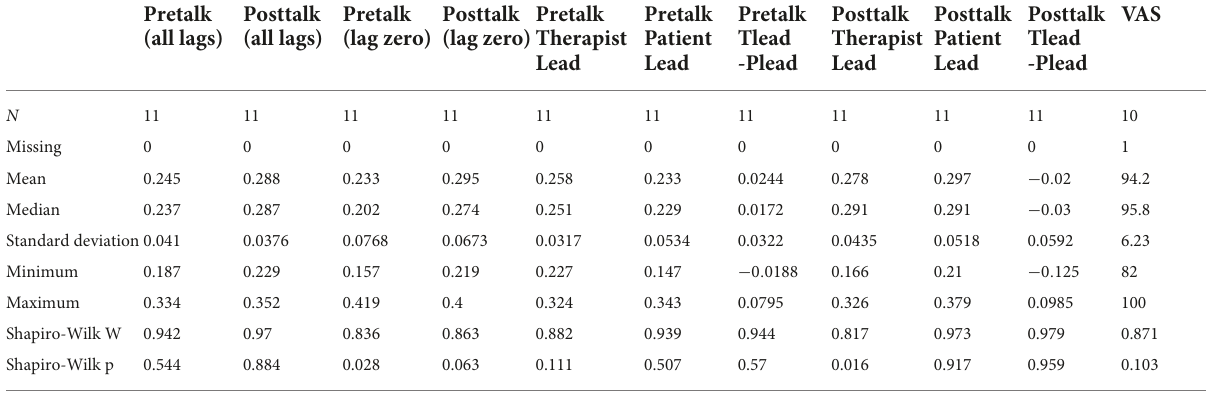
TABLE 3 Results of paired samples Wilcoxon